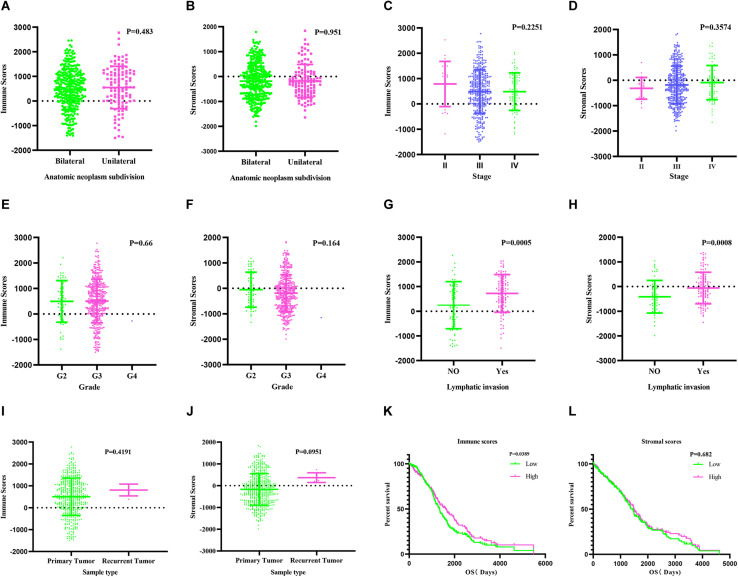
Immune and stromal scores are correlated with ovarian cancer clinical characters and their overall survival. (A,B) Distribution of immune and stromal scores of ovarian cancer anatomic neoplasm subdivision. (C,D) Distribution of immune and stromal scores of ovarian cancer stage. (E,F) Distribution of immune and stromal scores of ovarian cancer grade. (G,H) Distribution of immune and stromal scores of ovarian cancer lymphatic invasion. (I,J) Distribution of immune and stromal scores of ovarian cancer sample type. (K) Kaplan–Meier (KM) overall survival (OS) curve for high and low immune score group. (L) KM survival curve showing the OS time of high and low stomal score group.